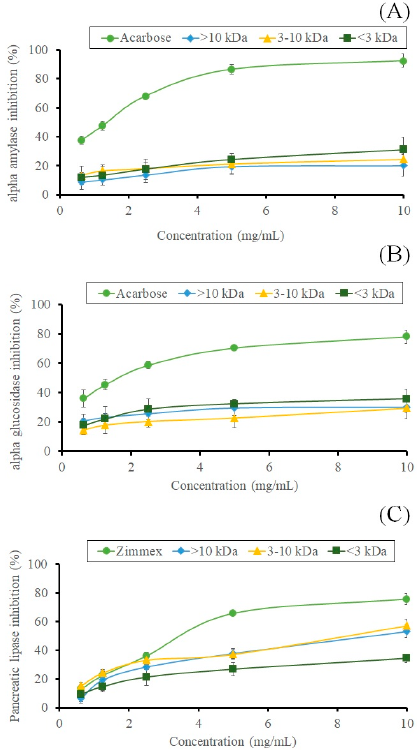
Figure 4. Anti–obesity effects of oligopeptide fractions. Inhibition of α –amylase ( A ), inhibition of α –glucosidase ( B ), and inhibition of pancreatic lipase ( C ) enzyme. Data expressed as mean ± SD, ( n = 3). Bars with different alphabets are significantly different at p < 0.05.